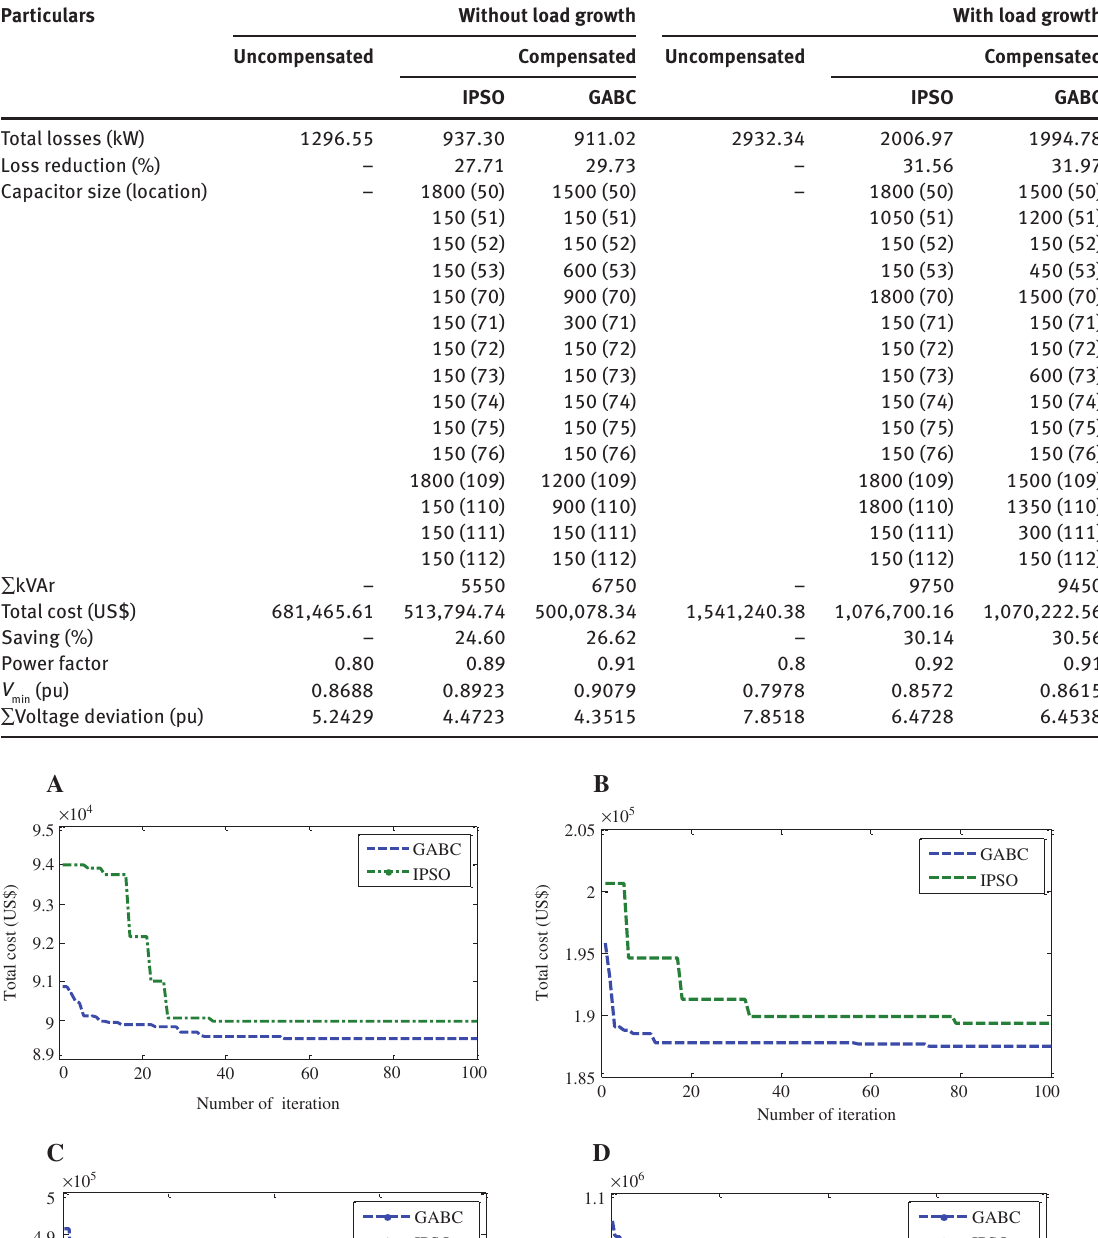
Table 16: Simulation Results of the 118-Bus Distribution Network after SC Placement Using the IVS Approach.